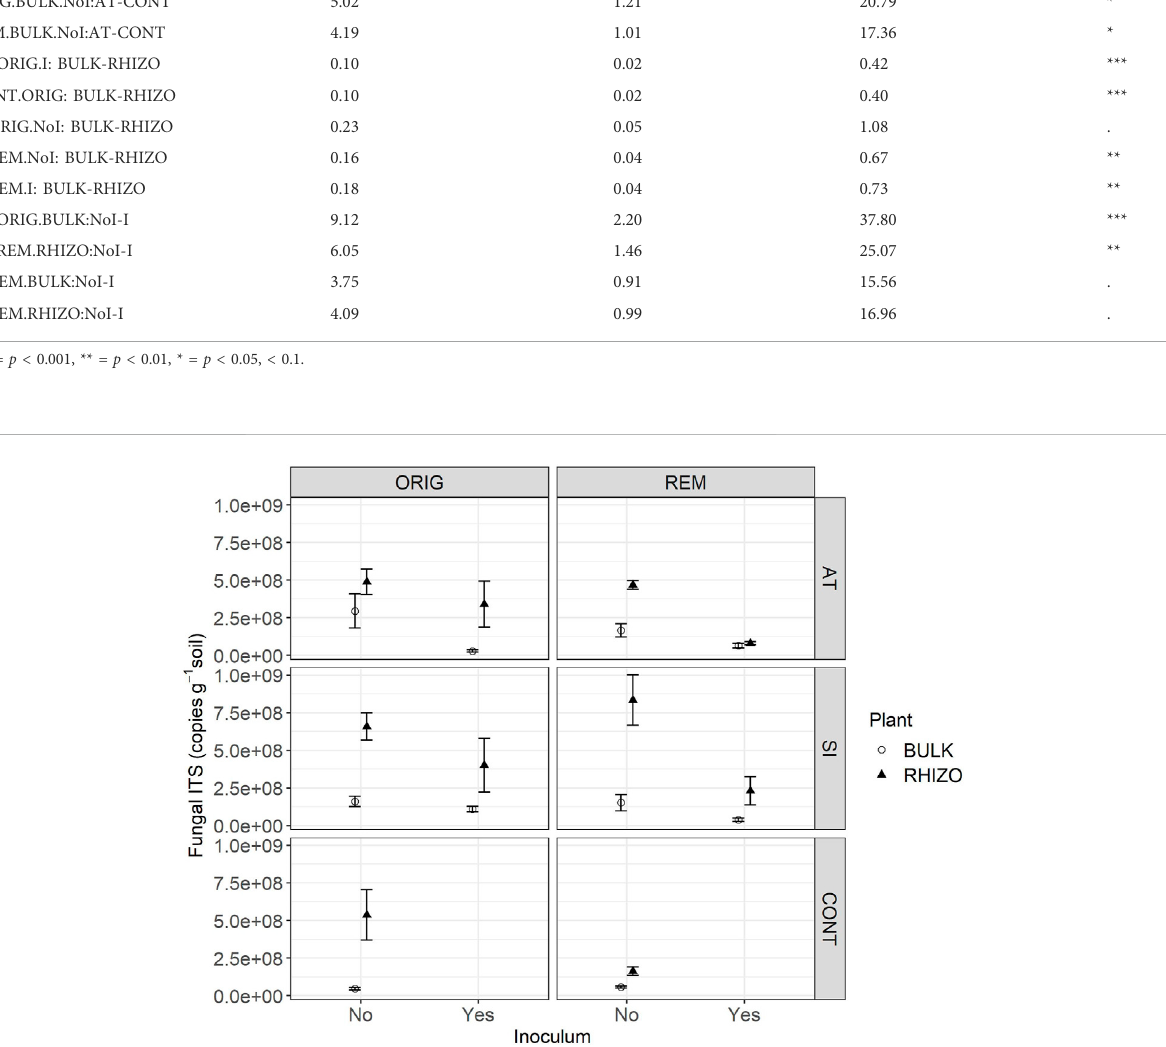
ITS gene abundance in AT ORIG BULK soil with inoculum was 23% (6 % – 96%) of that in SI ORIG BULK soil with inoculum. It also showed that the in fl uence of plant and inoculum on fungal abundance was different in different soils (AT, SI, CONT),